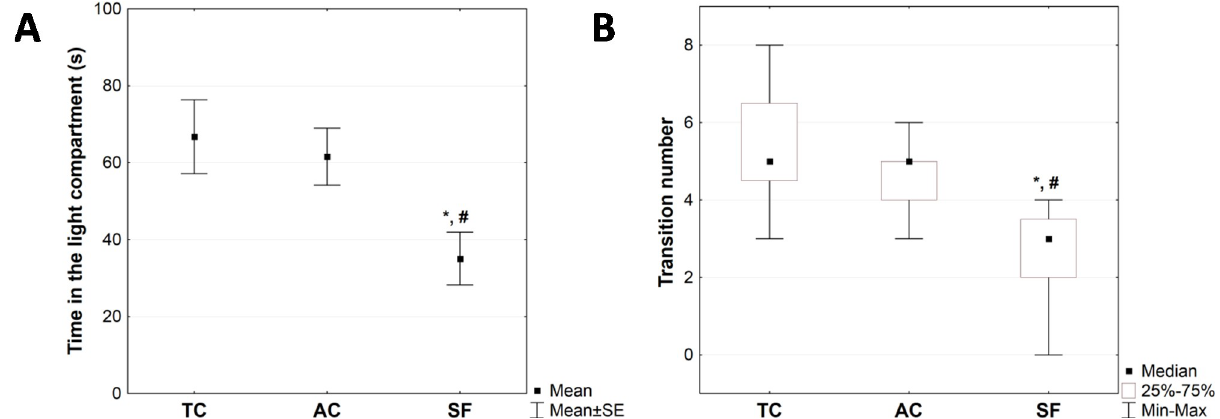
Fig 4. The time in the light compartment (A) and the number of transitions between the light and the dark compartment (B) in light/dark test observed in experimental and control groups. The statistical difference between groups in the time in the light compartment was estimated by using One-Way ANOVA with Fisher’s LSD post hoc test and in the number of transitions by Kruskall Wallis ANOVA and Mann Whitney U test ( � p < 0.05 vs. TC, #p < 0.05 vs. AC). For further details see caption to Fig 1.